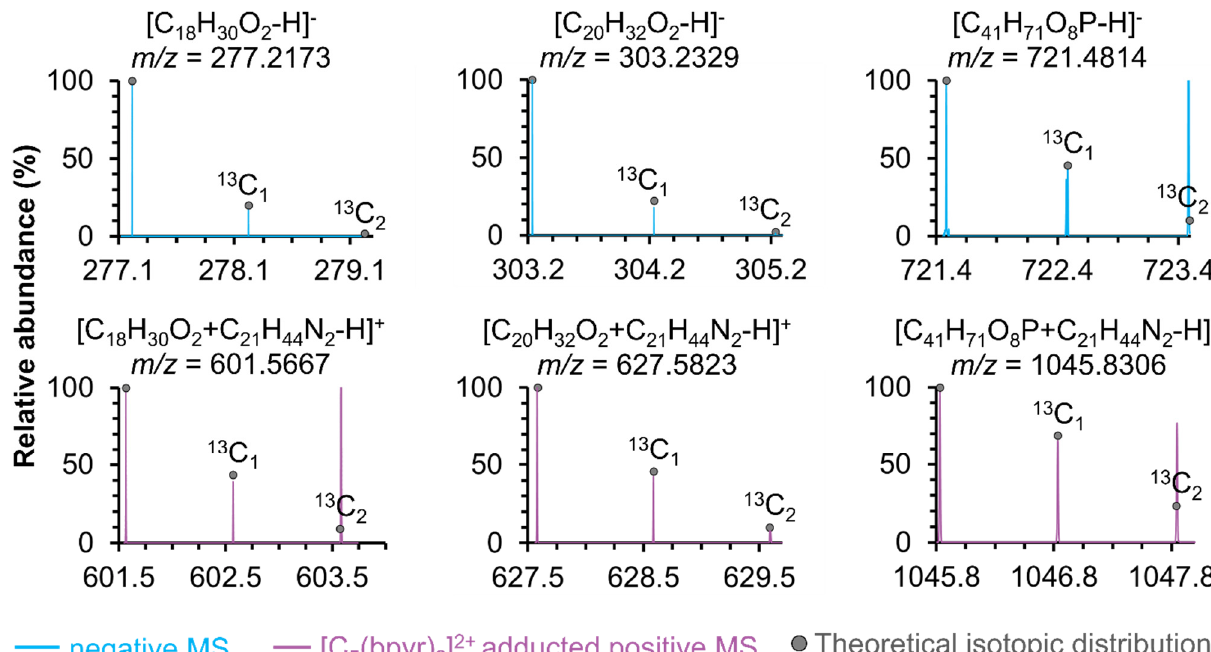
Figure 3. Spectral accuracy determination of three representative deprotonated metabolite ions in negative ionization mode (top, blue) and [C 5 (bpyr) 2 ] 2+ adducted positive ionization mode (bottom, purple), respectively. All background peaks were removed to clearly show the good alignment between the experimental MS spectra (shown in lines) and theoretical 13 C isotopic distribution (marked in grey dots).